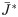
(A) Network with group b subdivided into two subgroups: stimulated neurons (b†, red) and unstimulated neurons (b∘, white). (B) Top: plots of equilibrium synaptic strengths J¯* between group a and both subgroups of b in normal activity and under spike-triggered stimulation (left/right resp.). Proportion of stimulated neurons is set to ρ = 0.5. Bottom: Plot of relative synaptic changes between equilibria: (J¯†-J¯)/Jmax. Control group c not shown. (C) Relative synaptic changes as a function of proportion of neurons in group b receiving stimulation ρ. Plotted are subgroup averaged synaptic changes for synapses from a to b† and b∘ and from a to entire group b. (d† = 30 ms)